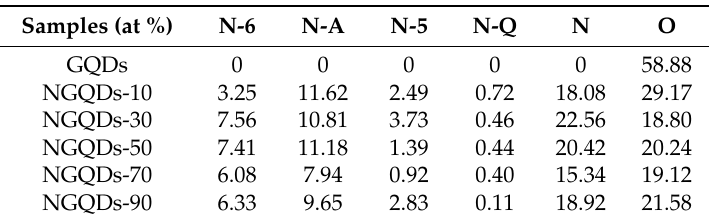
Table 1. The contents of nitrogen (N), oxygen (O), pyridine-like nitrogen (N-6), amino-like nitrogen (N-A), pyrrolic-like nitrogen (N-5), and graphitic-like nitrogen (N-Q) of the GQD and NGQD samples.